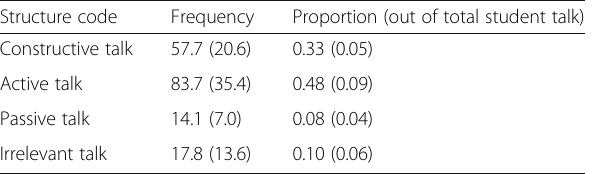
Table 4 Mean frequencies and proportions of student statements (with